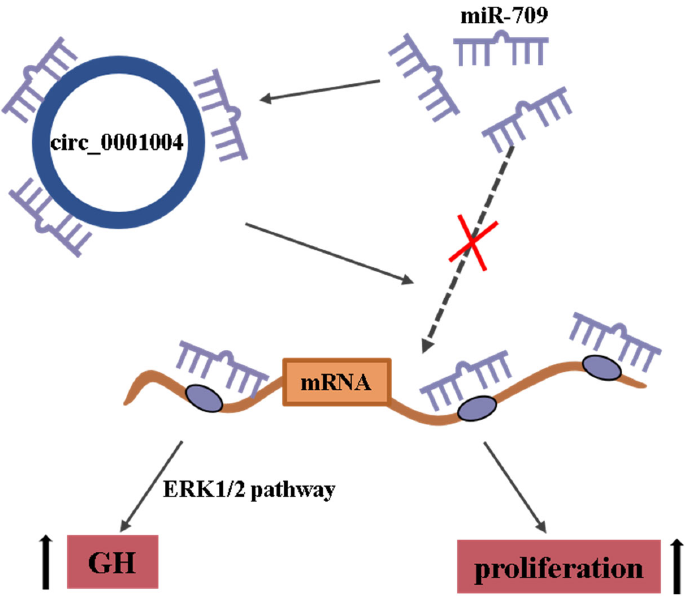
Figure 6. Rno_circ_0001004 has 3 miR-709 binding sites and can act as a miR-709 molecular sponge to regulate GH synthesis and cell proliferation.